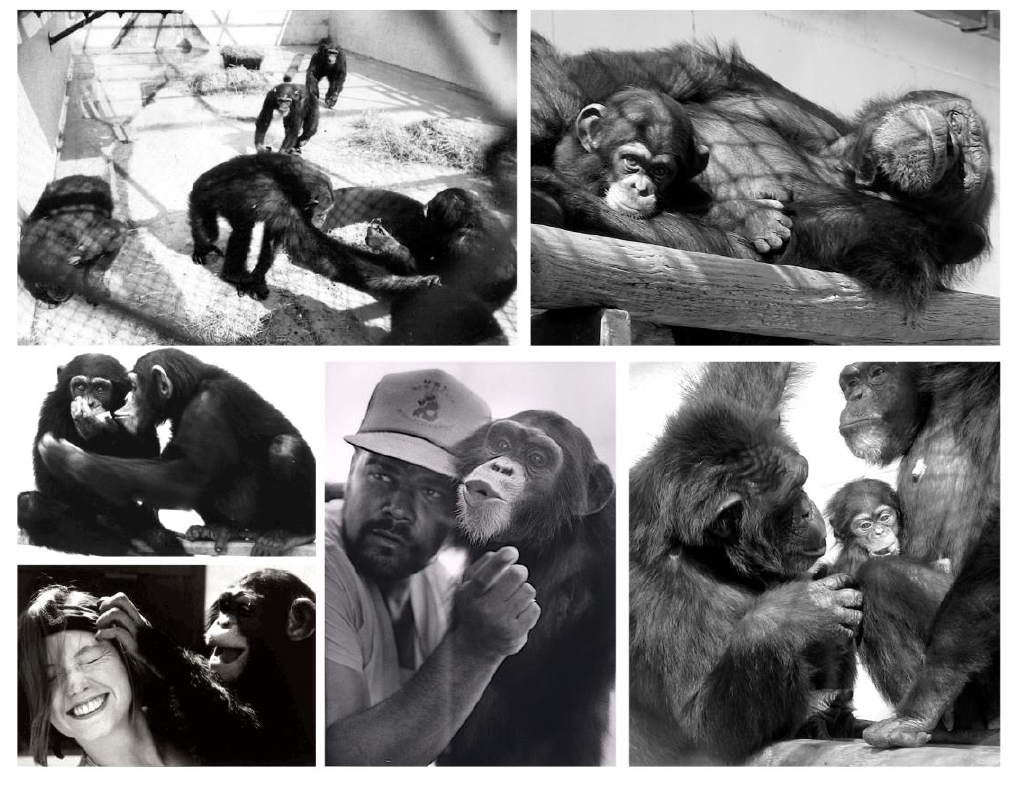
Candy and Her Companions, Growing Up Ape, in a Human